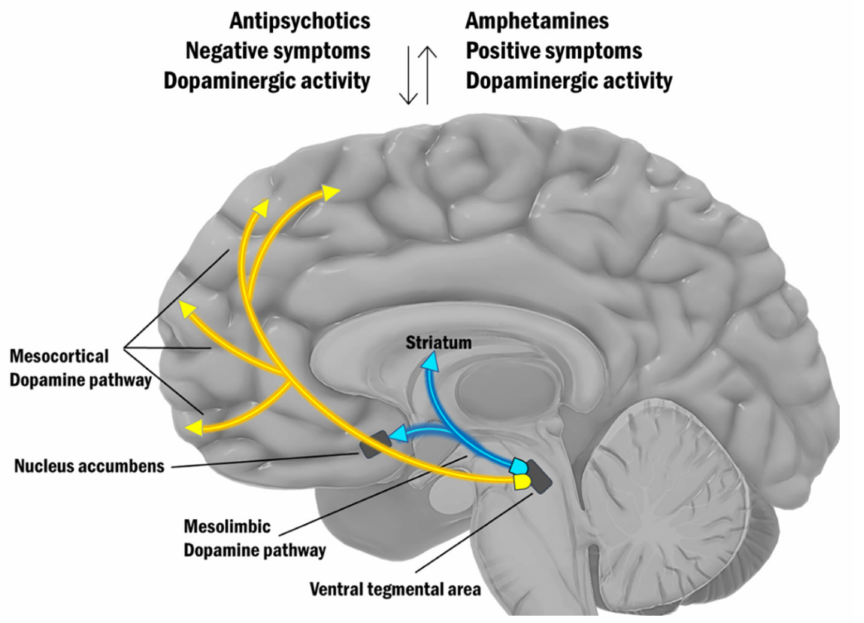
Figure 1. The dopamine hypothesis for